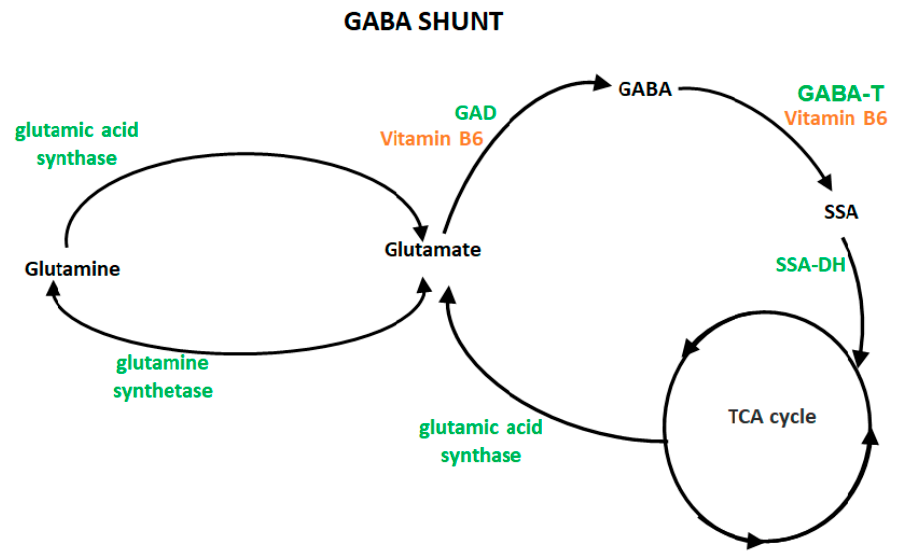
Figure 3. In the GABA shunt, GABA is synthesized from glutamate in a process catalyzed by GAD. GABA is metabolized by GABA-T into succinate semi-aldehyde, which is then reduced to gamma-hydroxybutyrate or oxidized to succinate and eventually converted to CO 2 and water via the TCA cycle. GAD, glutamatic acid decarboxylase; GABA-T, GABA transaminase; SSA, succinic semialdehyde; SSA-DH, succinic semialdehyde dehydrogenase; TCA cycle, tricarboxylic acid cycle. Green, enzymes; Orange, cofactor.